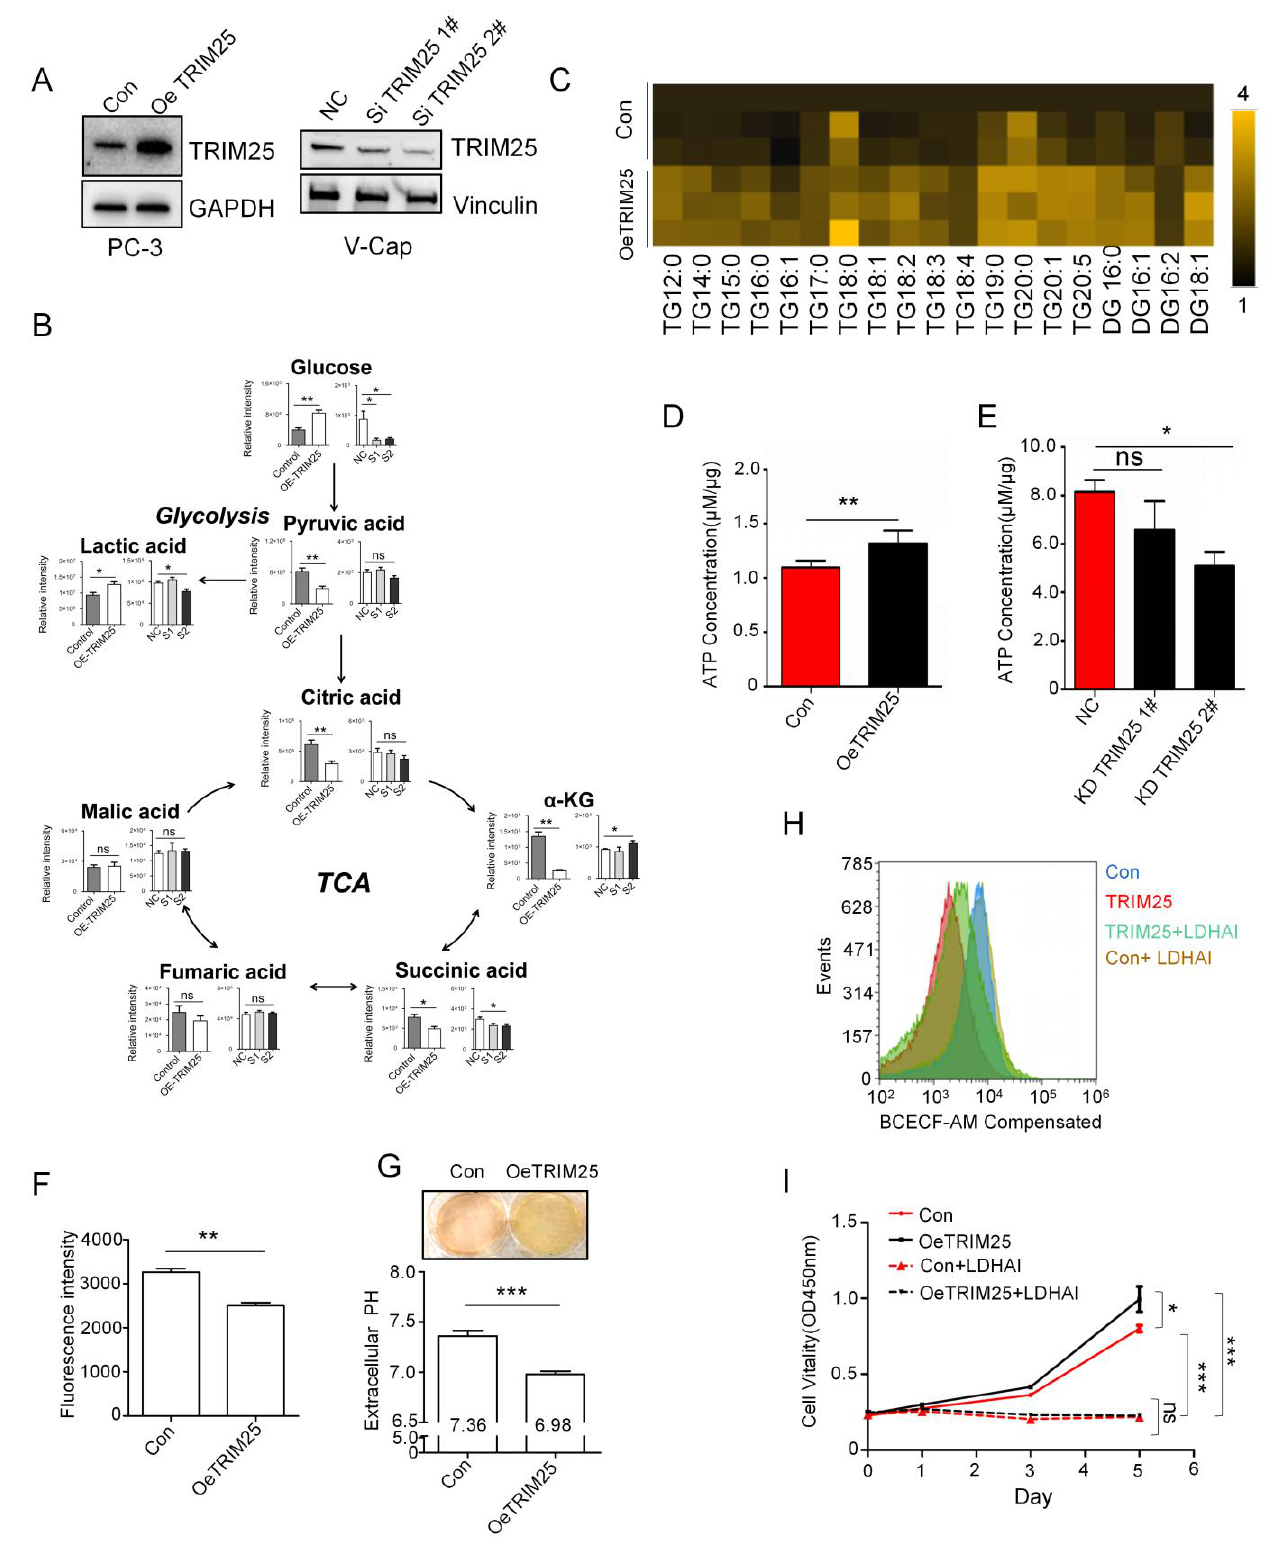
Figure 2. TRIM25 promotes glycolysis and upregulates cellular lactic acid secretion. ( A ) TRIM25 protein level in stable overexpression PC3 and RNAi knockdown V-Cap cells. ( B ) GC–MS detected metabolites of glycolytic and TCA cycle in TRIM25 overexpression PC3 and knockdown V-Cap cells. NC, negative control; S1, SiTRIM25 1#; S2, SiTRIM25 2#. ( C ) Heat map showing lipid level